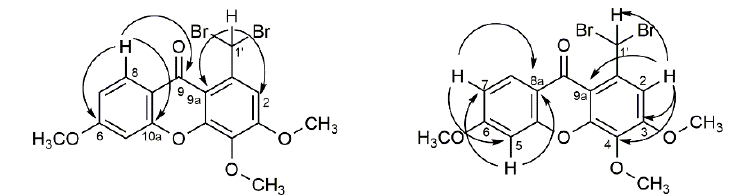
Figure 2. Most relevant chemical shifts and key HMBC correlations of 1-(dibromomethyl)-3,4,6- trimethoxy-9 H -xanthen-9-one 8 .